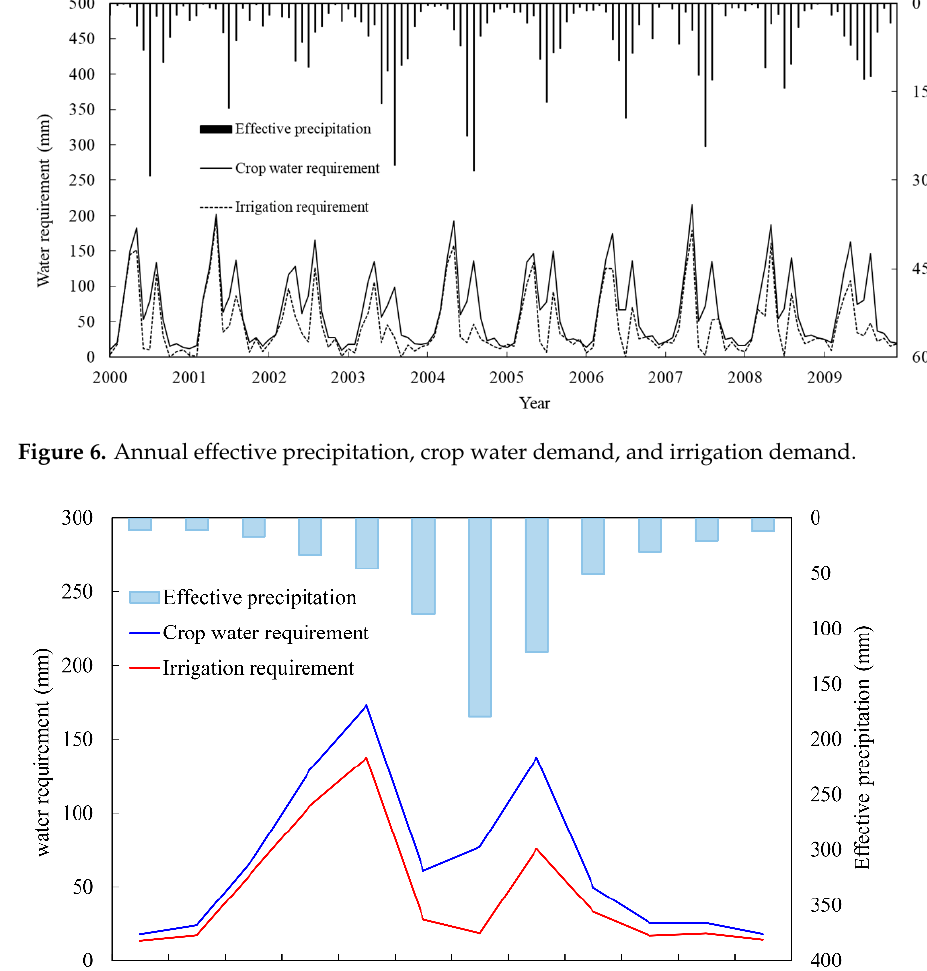
Figure 7. Monthly effective precipitation, crop water demand, and irrigation demand.